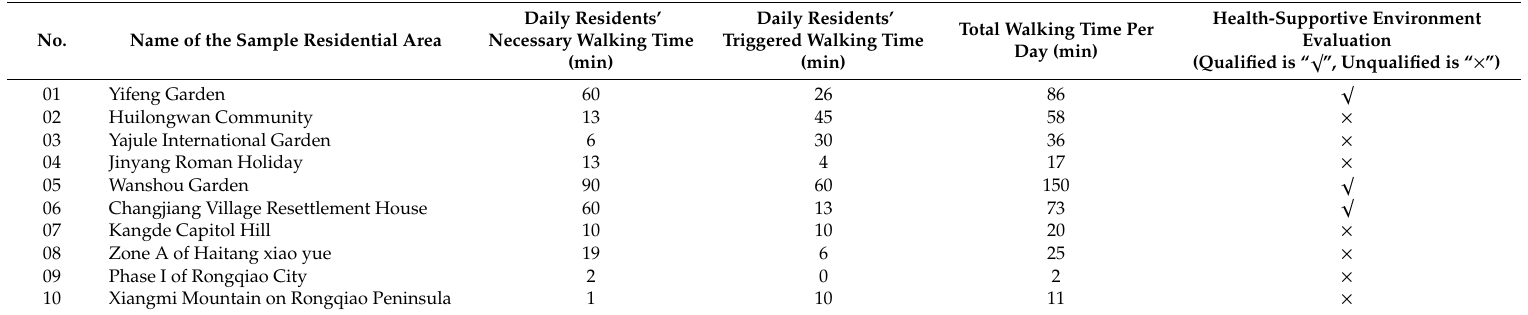
Table 8. Health-supportive environment evaluation 1 .